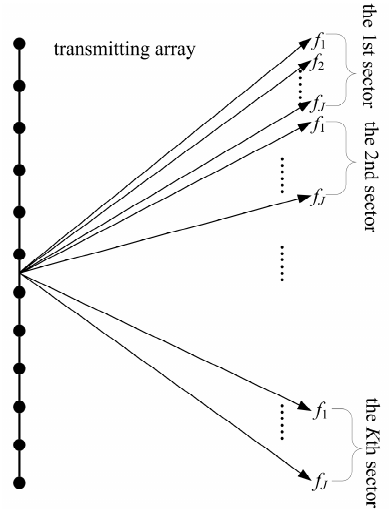
Figure 3. Transmitting process of the multi-frequency (MF) algorithm.